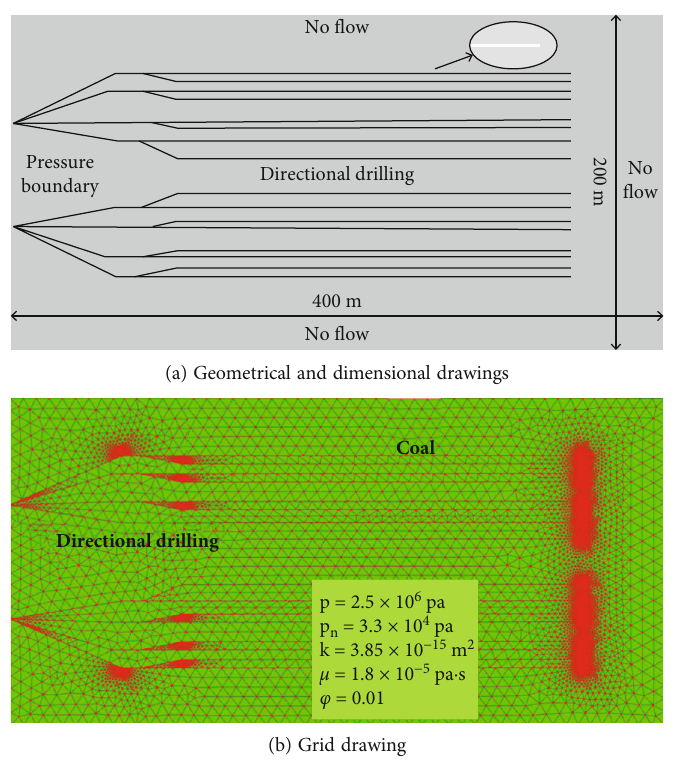
Figure 2: Geometric diagram and grid diagram of gas extraction model in directional